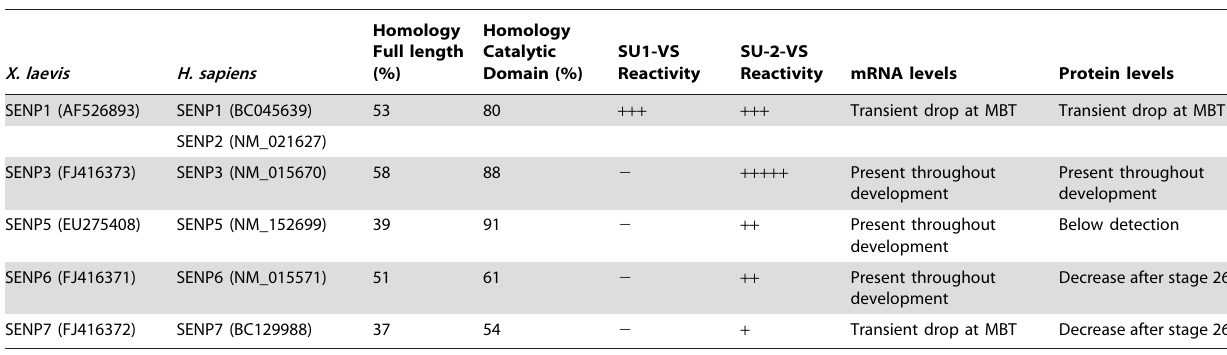
Table 1. Characteristics of X. laevis